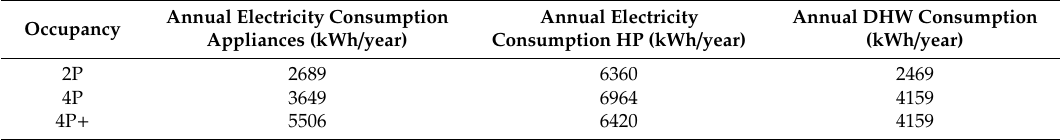
Figure 5. Occupancy, household electricity, and domestic hot water use profile for 4P for a random day in Sweden. ( a ) Occupancy, ( b ) household electricity and ( c ) domestic hot water load profile. Table 6. Electricity and domestic hot water (DHW) demands in Sweden for the three different profiles used in the study.